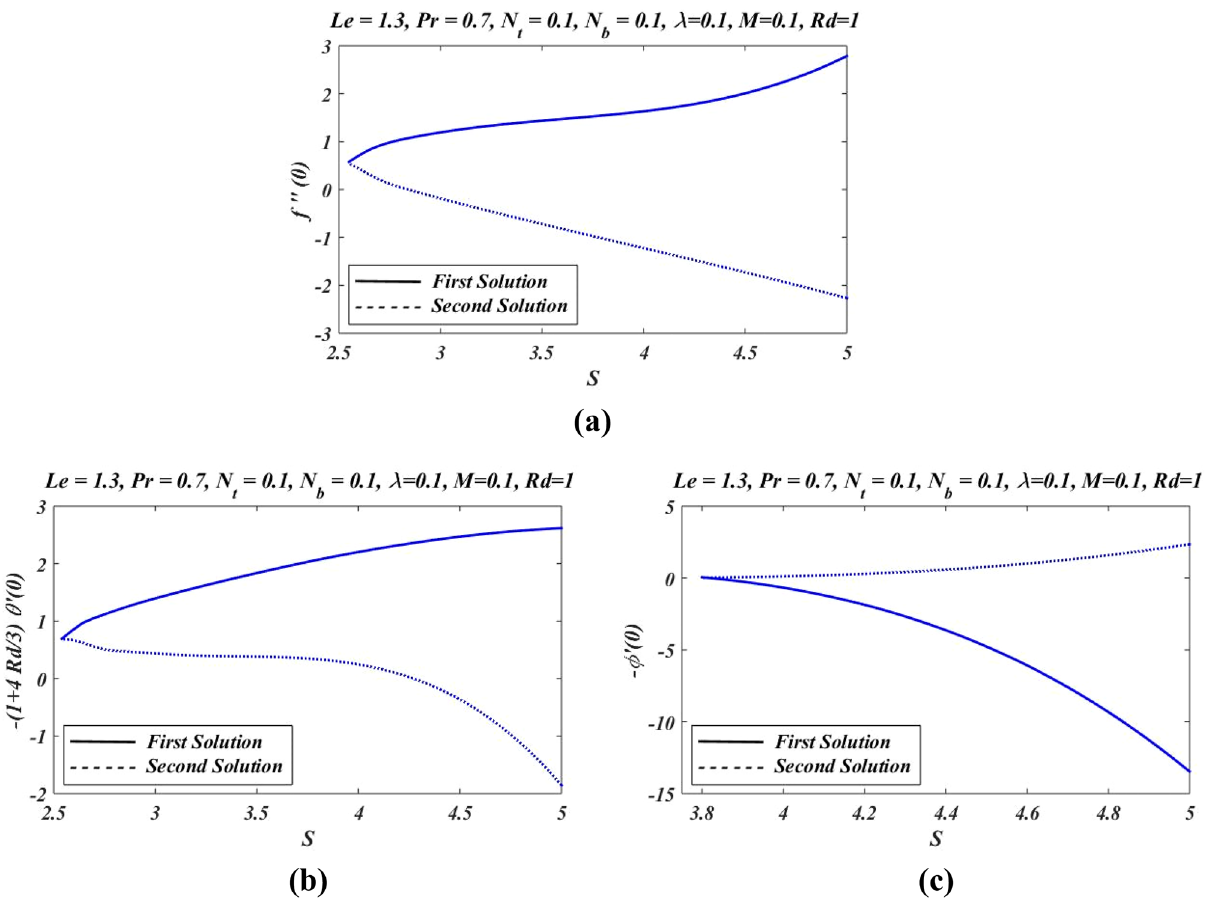
Figure 10. Graphs of ( a ) skin friction, ( b ) temperature gradient and ( c ) nanoparticle volume fraction